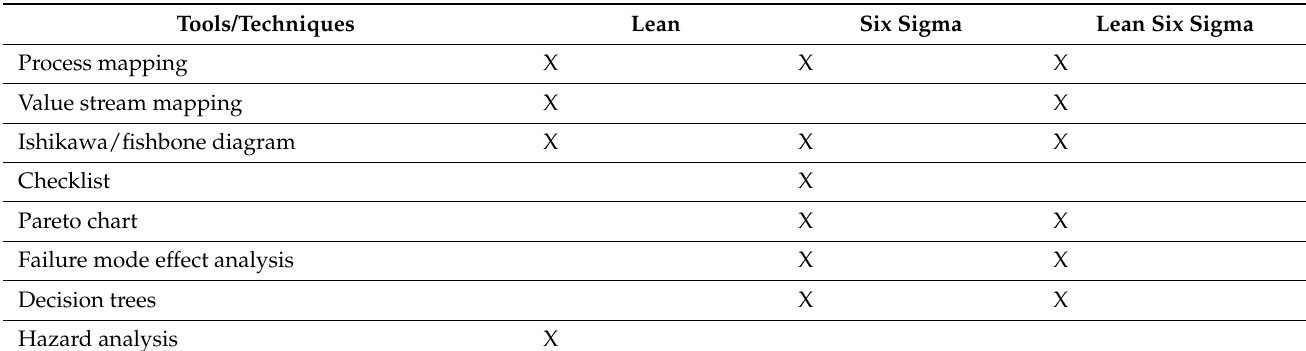
Table 4. Classification of various tools/techniques in